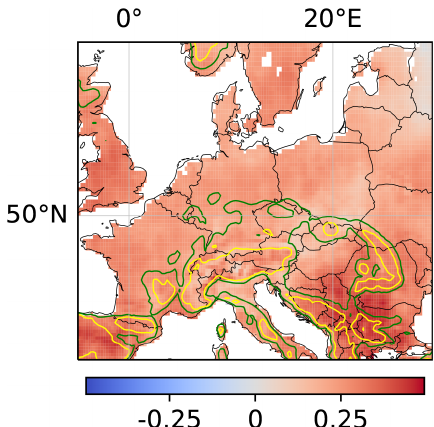
Figure 7. Linear correlation coefficient of local soil moisture and regional precipitation. For each location, the linear correlation co- efficient of soil moisture SM [ t ] at the location and subsequent pre- cipitation P [ t + 4h ] summed over the 15 × 15 pixel surrounding region of the location is